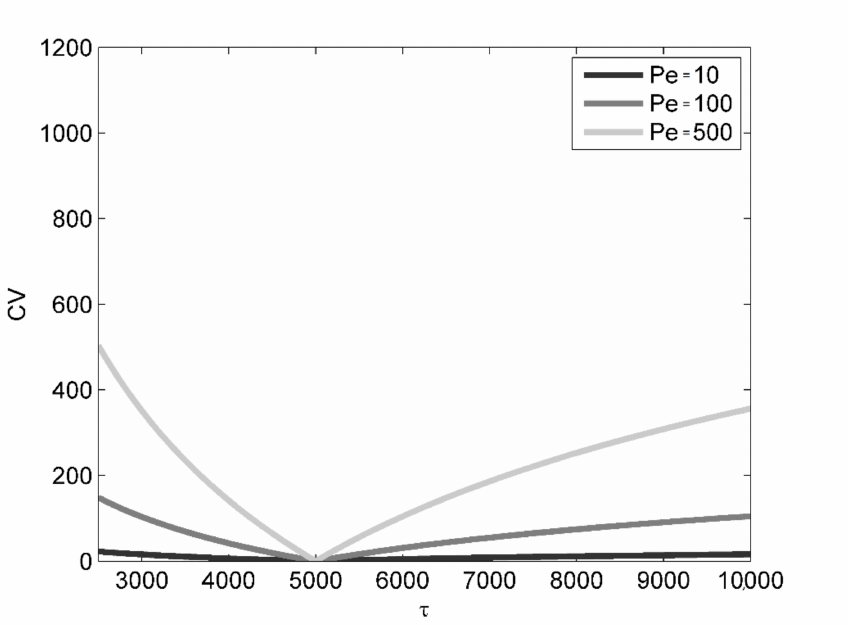
Figure 4. Concentration coe ffi cient of variation at a fixed point in space σ 2 coe ffi cient of variation; τ is the dimensionless time.